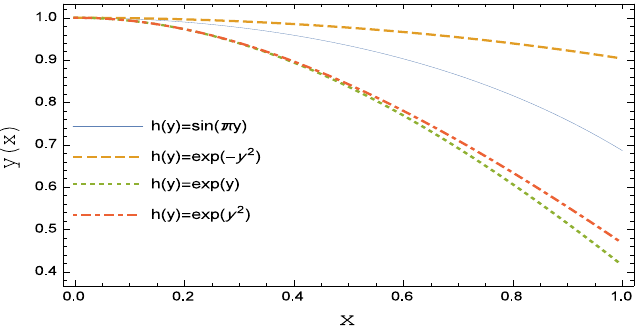
Figure 5. Graph of approximate solutions of the Example 2 for various h ( y ) with m=10 iterations and N = 50.